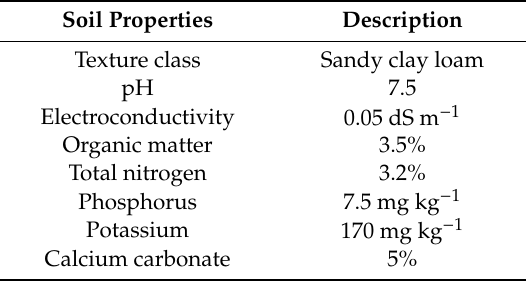
Table 2. Description of soil properties at 30 cm depth in the experimental